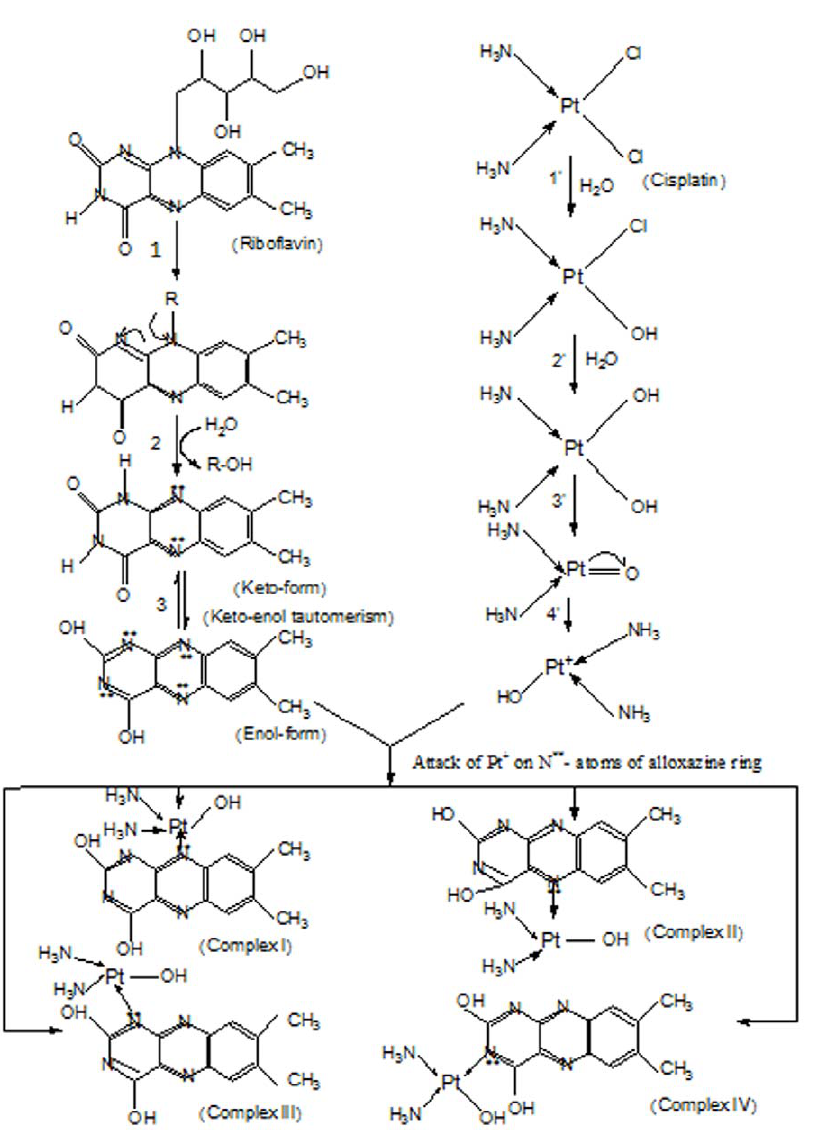
Figure 7. Putative mechanism of complex formation between riboflavin and cisplatin. Bio-activated form of cisplatin may eventually become electron-deficient compound and can interacts with electron-rich alloxazine ring N-atoms of riboflavin (keto-enol forms) in aqueous medium resulting into formation of four complexes of both the compounds.